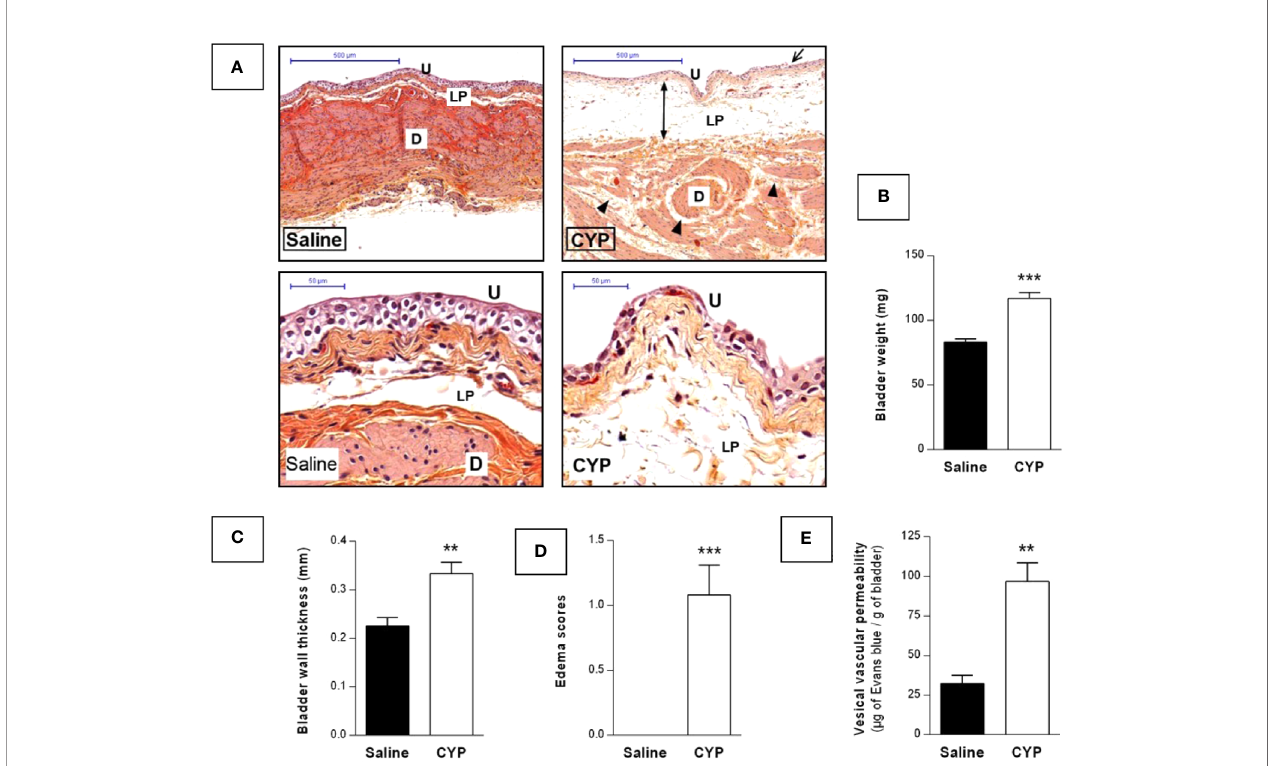
FIGURE 5 | Repeated injections of low dose of CYP induced chronic bladder in fl ammation. Cystitis was induced as described previously and urinary bladders were collected at D10. (A) Representative H&E-stained sections of bladder from saline or CYP-injected rat. Edema in detrusor and lamina propria are indicated by arrowheads and injured urothelium is shown by arrows. Abbreviation used: D, detrusor; LP, lamina propria; U, urothelium. Scale bars, 500 µm (top images) and 50 µm (bottom images). Collected bladders were assessed for (B) weight, (C) wall thickness, and (D) edema scoring (n = 12/group). (E) Quanti fi cation of vesical vascular permeability assessed by Evans blue extravasation, 10 day after saline (n=5) or CYP (n=7) fi rst injection. Data represent mean values ± SEM. **p < 0.01, ***p < 0.001 [ B , unpaired t test with Welch ’ s correction; (C – E) , Mann Whitney